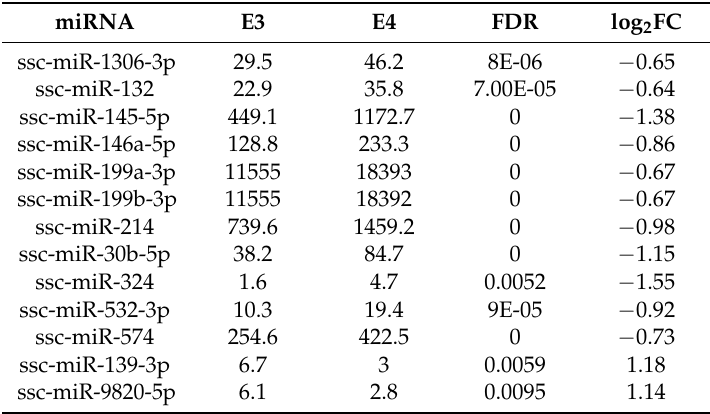
Table 6. Differential miRNA screening in D-N1ICD vs.